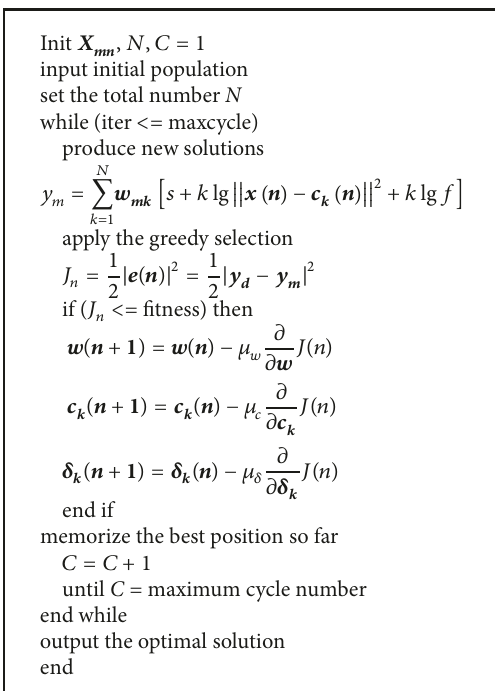
Algorithm 2: Program diagram of the RBFABC algorithm.